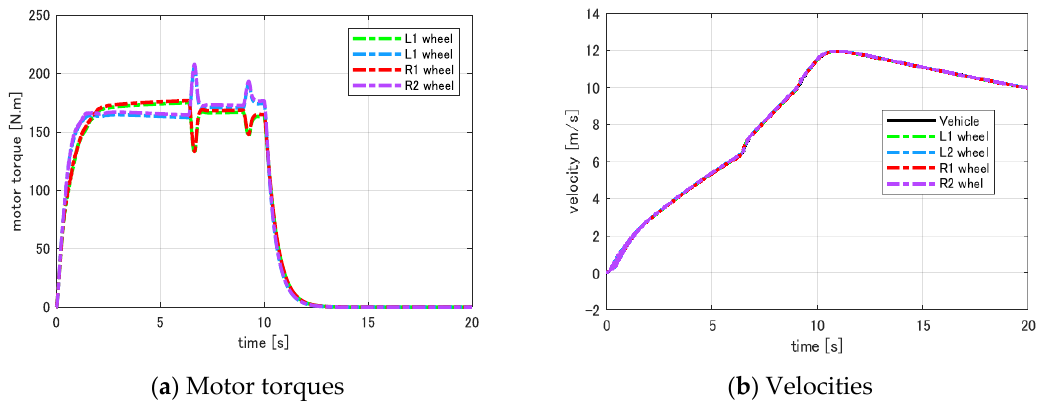
Figure 19. Simulation results of wheel velocity control using DM-2.